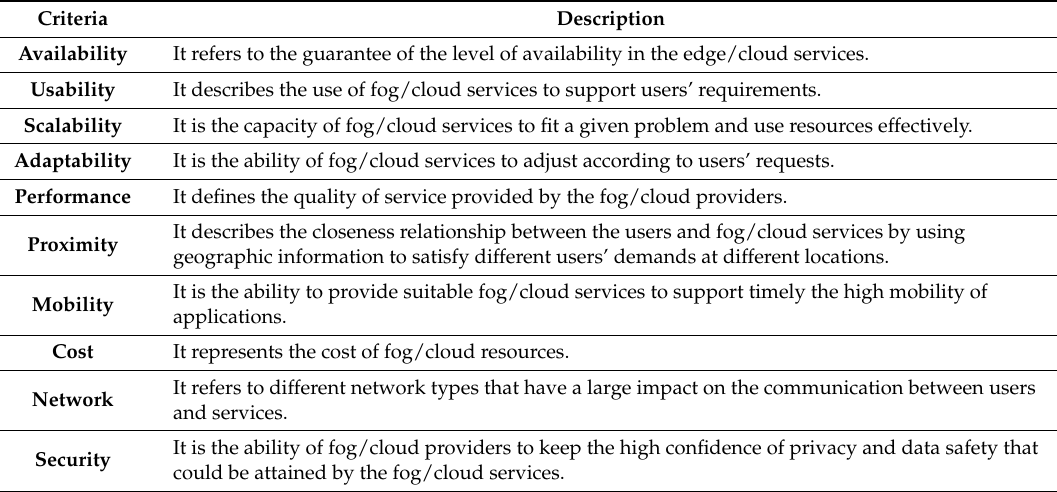
Table 2. Table 2. Criteria.